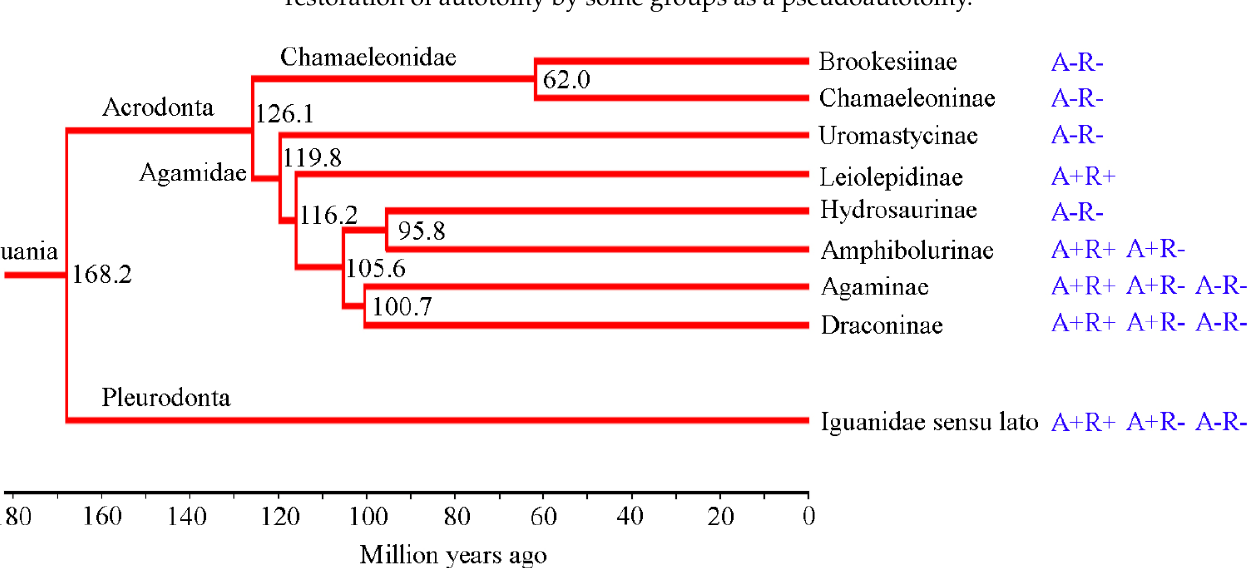
Figure 4. Different types of tail regenerates of agamid lizards of different subfamilies. 1. Leiolepis belliana (China, ZISP 17166); 2. Leiolepis guentherpetersi (Vietnam, ZISP 21877); 3. Leiolepis guttata (Vietnam, ZISP 20354); 4. Intellagama lesueurii (Australia, ZISP 20455); 5. Laudakia nupta (Persia (Iran), ZISP 23890); 6. Laudakia nupta ((Iran, ZISP 11403); 7. Laudakia nupta